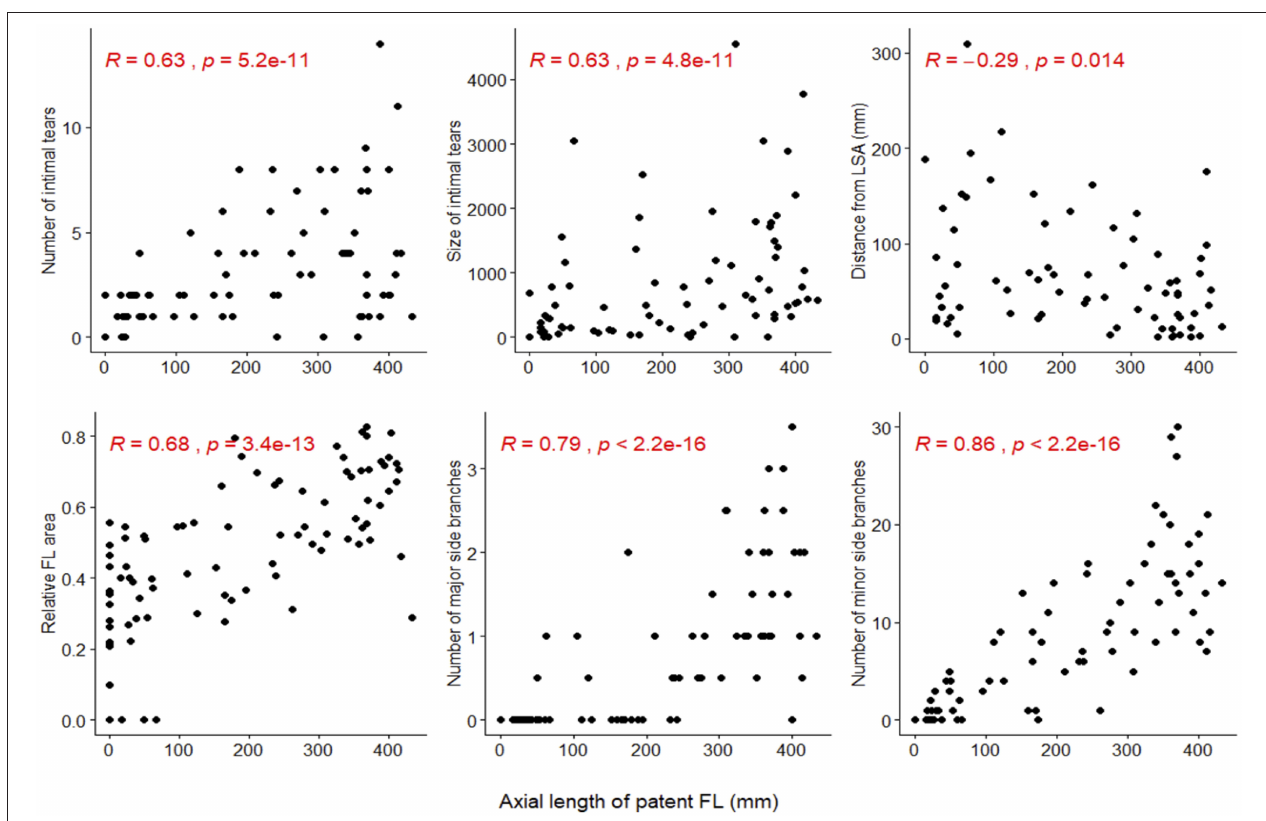
FIGURE 2 | Correlation between the axial length of the patent false lumen (FL) (x-axis) and the number and size of intimal tears, the distance from the left subclavian artery (LSA) to the most proximal intimal tear (distance from LSA), the relative FL area, and the number of major and minor side branches arising from the FL (y-axis). Spearman’s rank correlation was applied and the corresponding p -value is displayed for each scatter-plot.